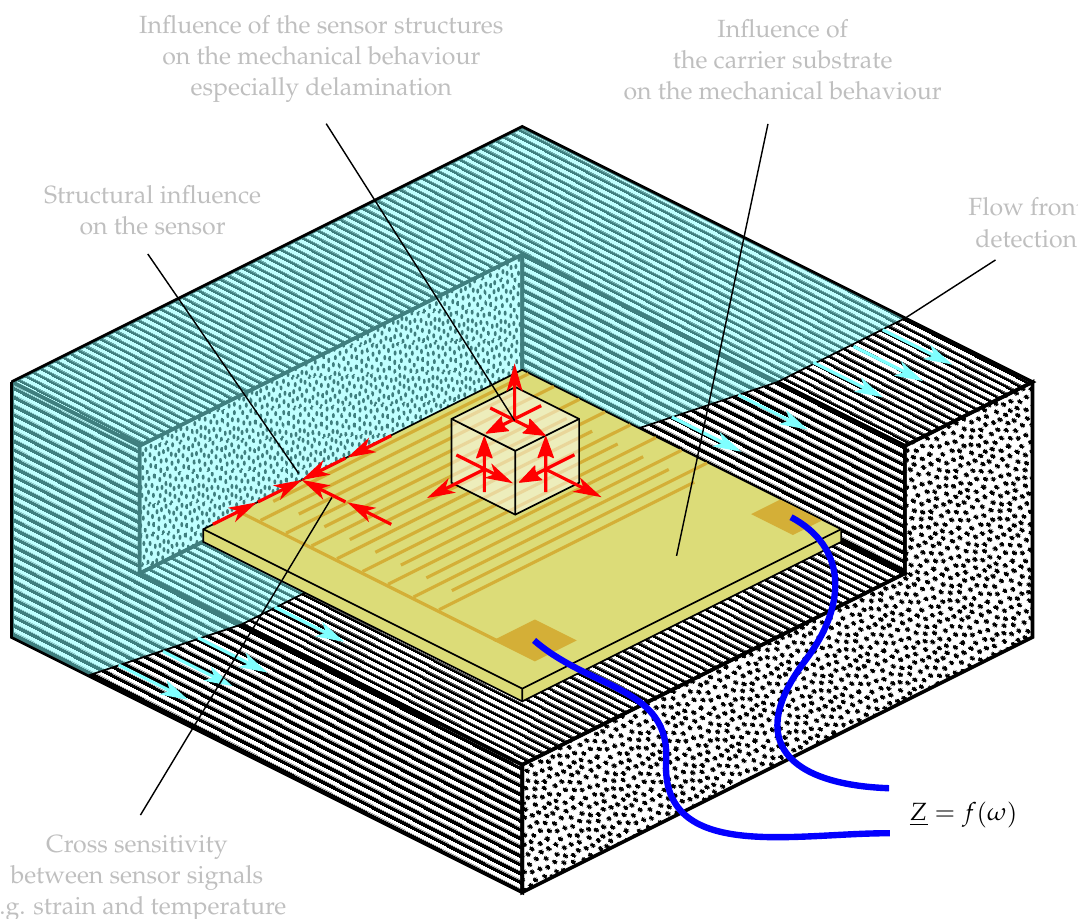
Figure 1. Questions arising from the embedding situation of a film sensor for fibre composite manufacturing